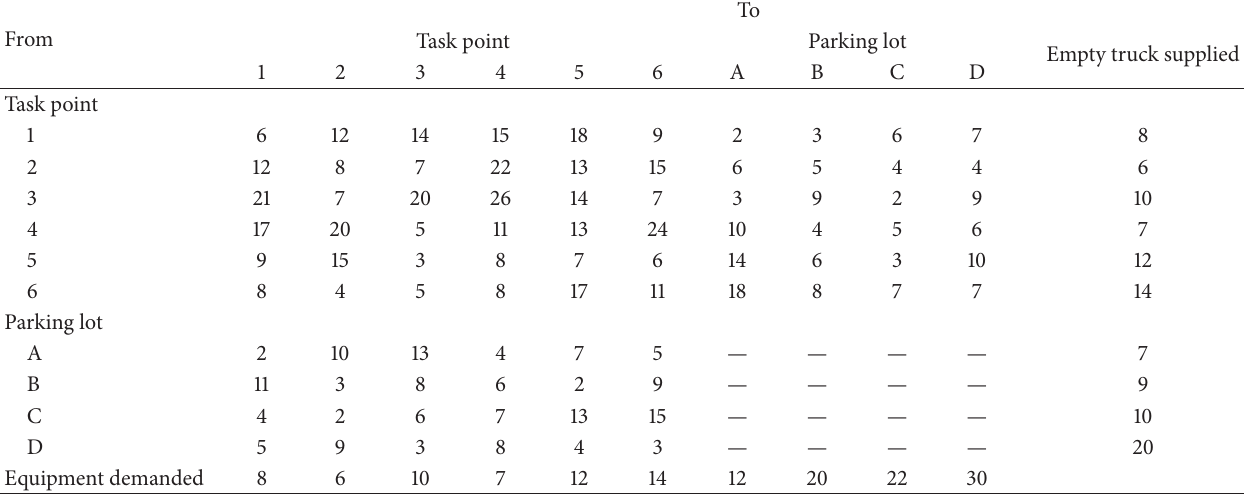
Table 2: Deadhead distances and construction devices supply